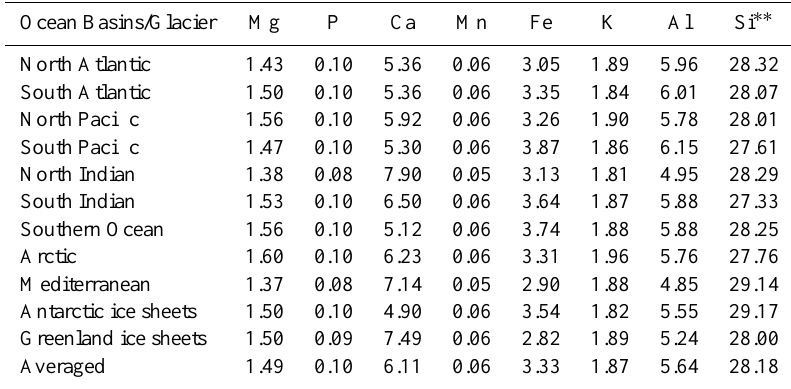
∗ After timing tuned ratios (Table 3) except for Si. ∗∗ Non tuning. (For this table, annual mean deposition of each element is divided by the annual mean deposition of dust to obtain the